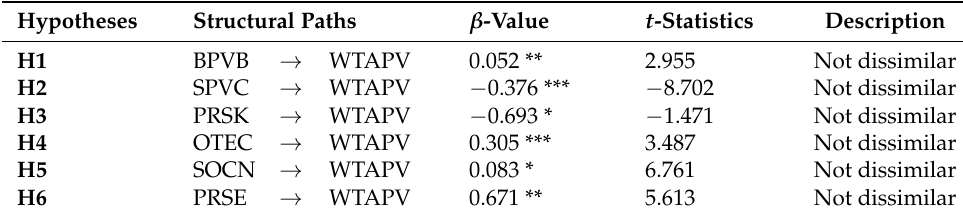
Table 14. Endogeneity